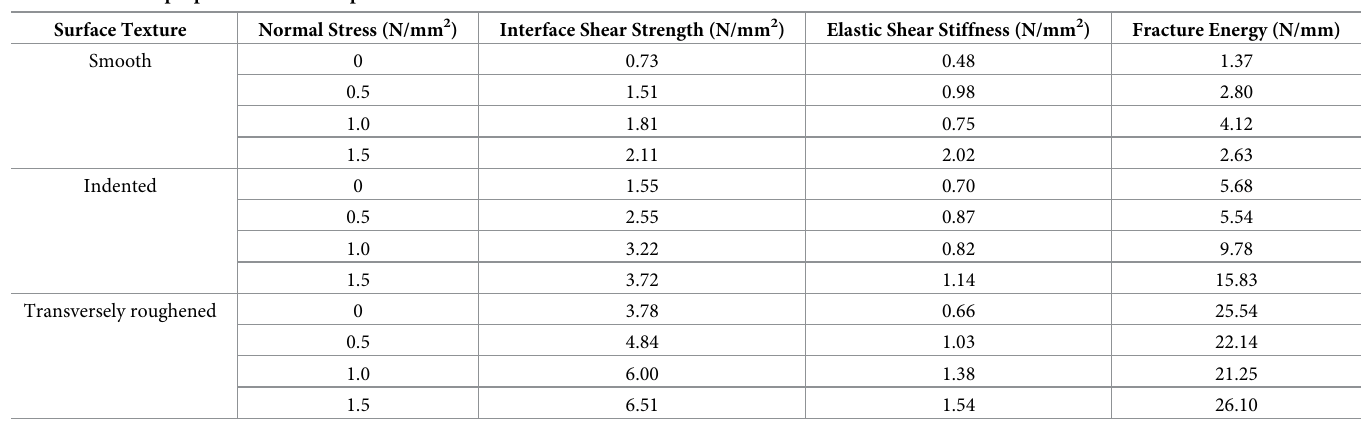
Table 1. Interface properties for the composite concrete.